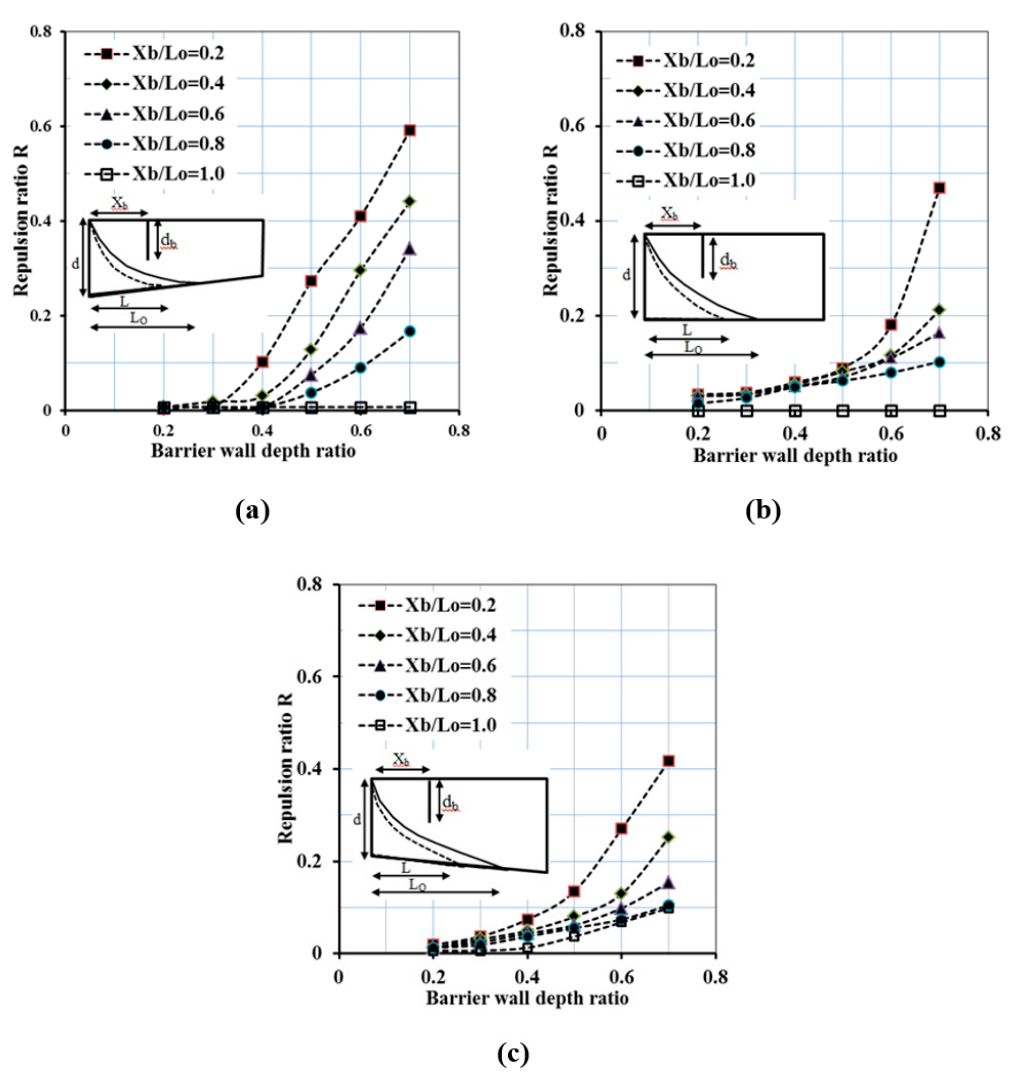
Figure 7. Relationship between the barrier wall depth ratio and R for ( a ) tan β = 0.02, ( b ) tan β = 0.0, and ( c ) tan β = − 0.02.